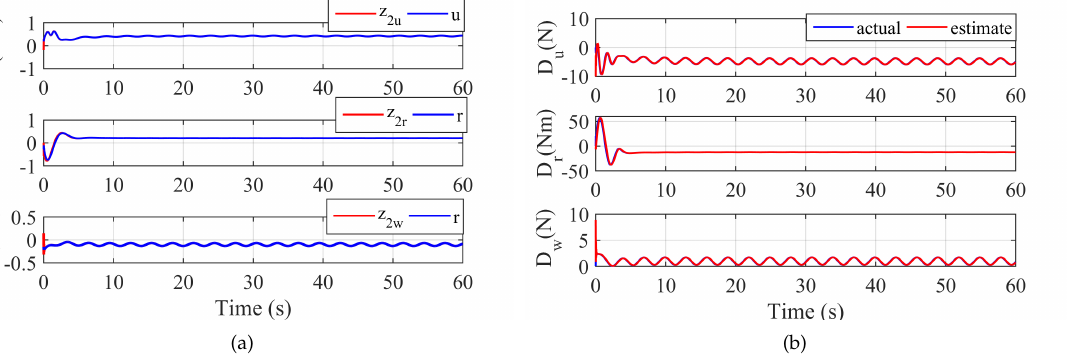
Figure 13. The estimations of velocity and lumped disturbances. ( a ) The estimated value of the velocity; ( b ) The estimated value of the lumped